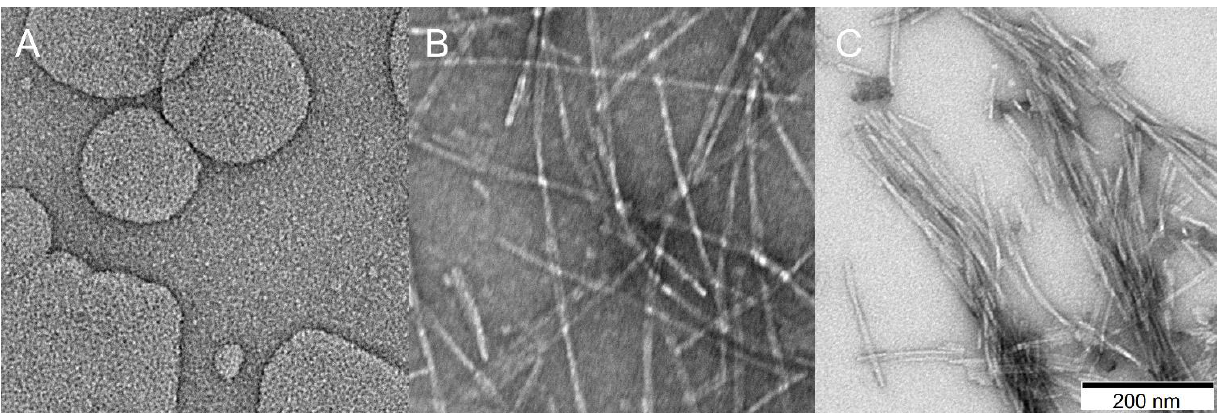
Figure 9. Comparison R4 fragments. ( A ) E. coli on the day of dissolving ( B ) S. enterica on day of dissolving ( C ) E. coli after 7 days of incubation in 37 °C. Images registered at the magnification of 200 nm. Peptide concentration was 0.5 µM.